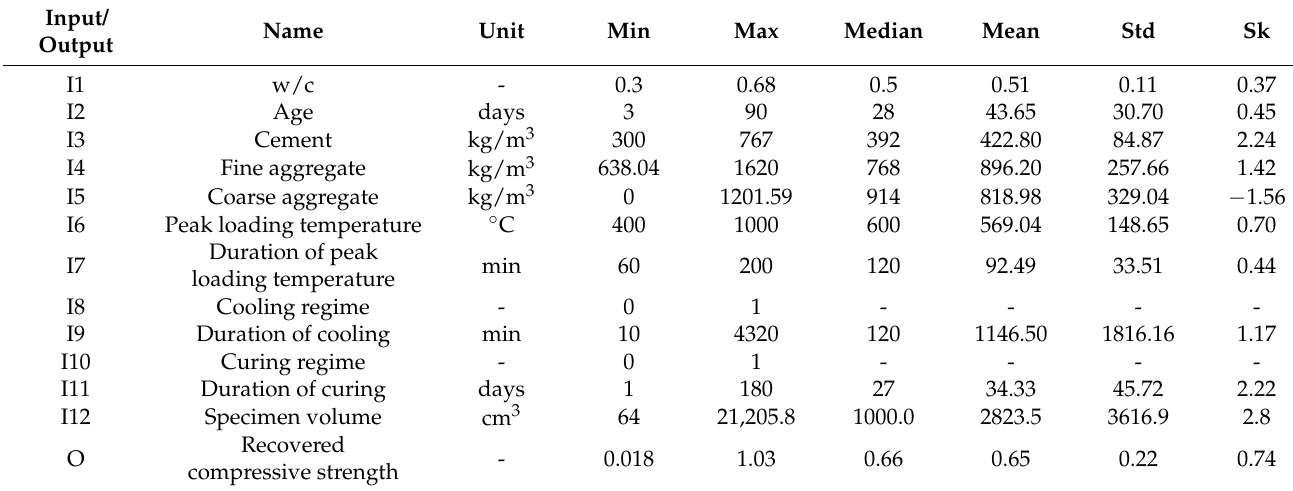
Table 3. Statistical descriptors of the input and output parameters.